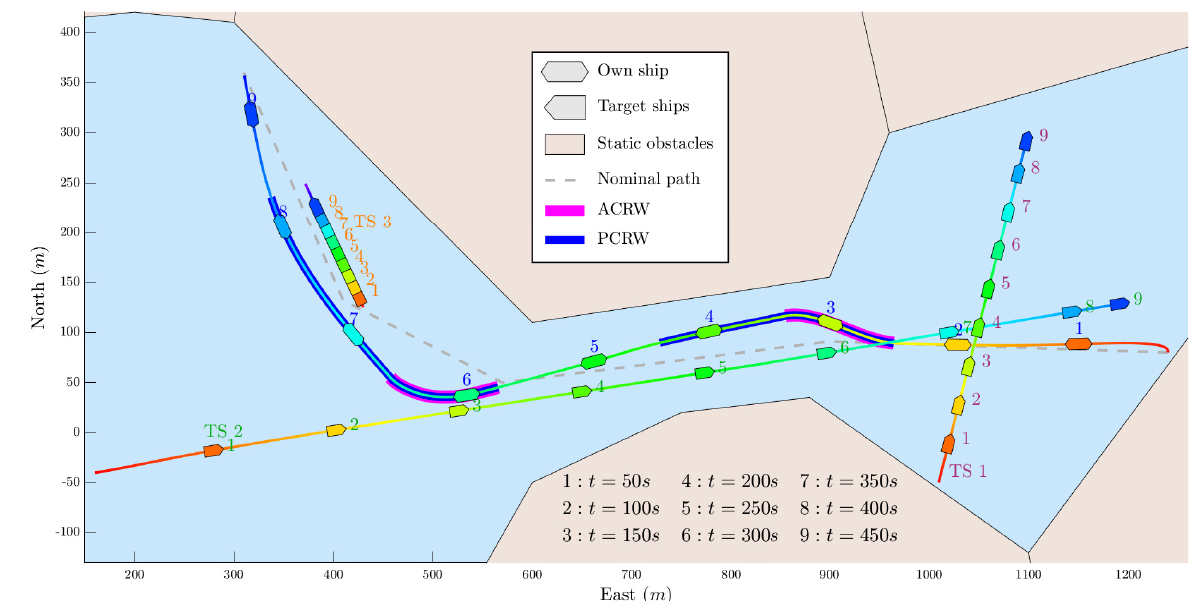
Figure 16: Simulation 2: Transit between two docking locations, with a stand-on, head-on and overtaking encounter.